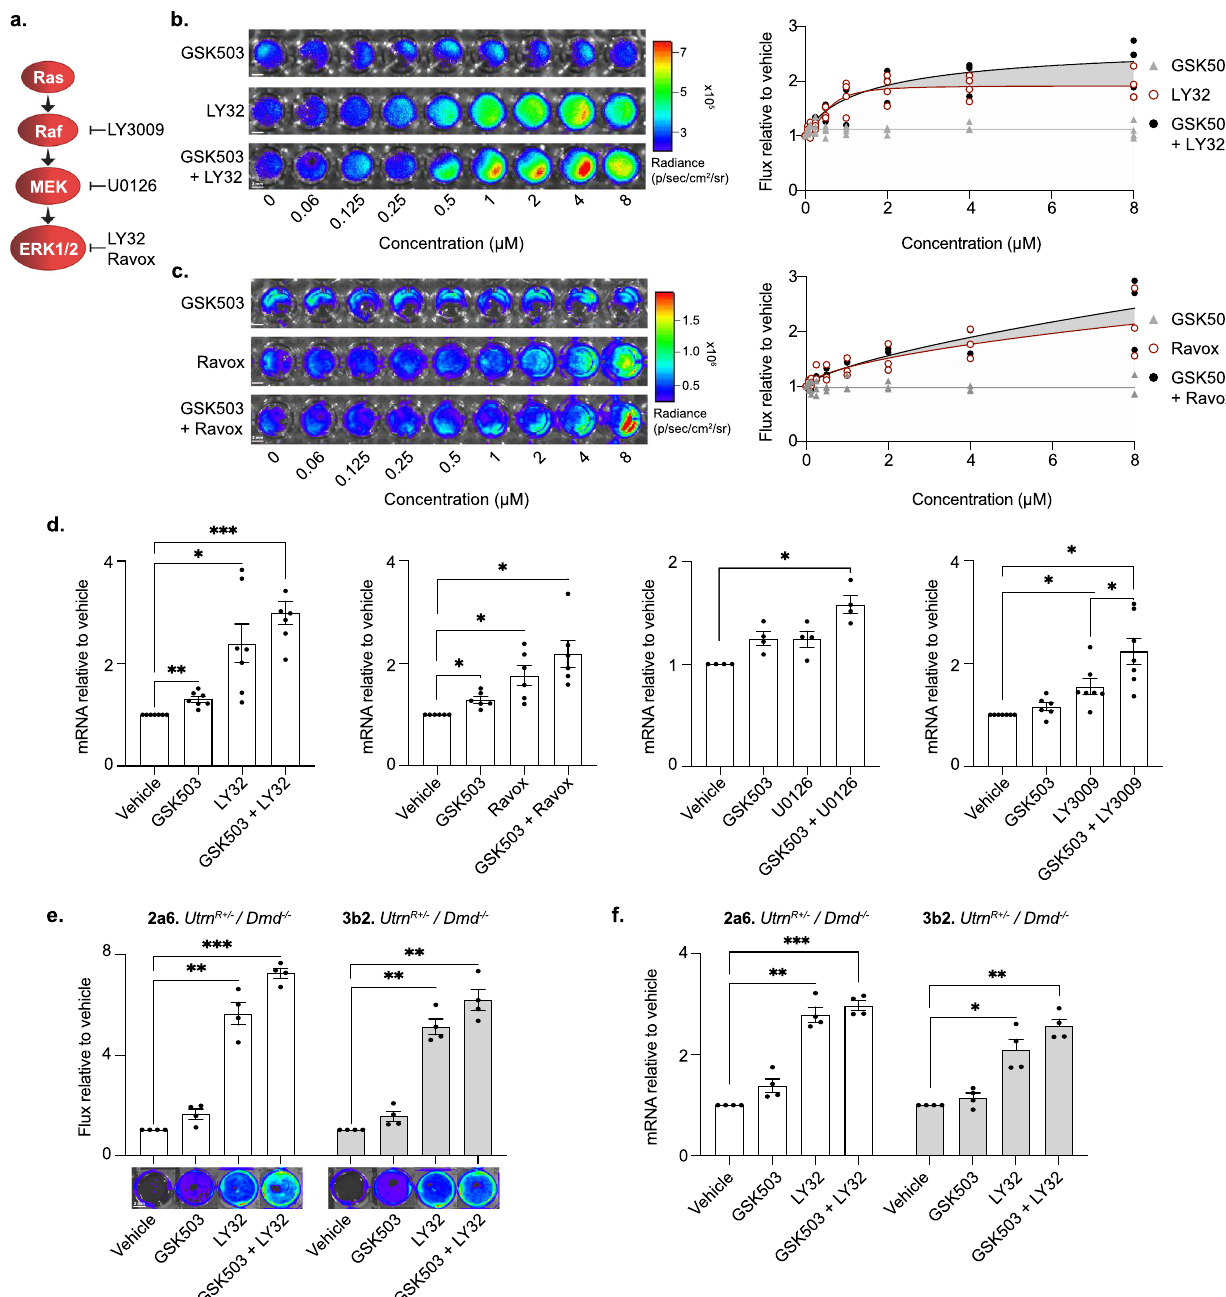
Fig. 5 ERK inhibitors combined with EZH2 inhibitors increased Utrn expression in adult myoblasts. a Schematic of the ERK signalling pathway and the inhibitors used in this study. b Bioluminescence image (left) and quanti fi cation of fl ux (right) of U22 A5 myoblasts after 24 h treatment with EZH2i GSK503 (grey triangles) or ERKi LY32 (red open circles) alone or in combination (black closed circles). LY32 treatment caused a dose-dependent increase in fl ux which was further ampli fi ed by the addition of GSK503 (shaded area). c As in b , for U22 A5 myoblasts treated with EZH2i GSK503 (grey triangles) and ERKi Ravox (red open circles) either alone or combined (black closed circles). A dose dependent increase in fl ux was observed after Ravox treatment and this was increased upon the addition of GSK503 (shaded area). d RT-qPCR of U22 A5 myoblasts after 24 h treatment with GSK503 and ERK pathway inhibitors (at 10 µ M), applied either alone or combined; increased Utrn mRNA upon treatment with ERK pathway inhibitors was ampli fi ed by the addition of GSK503. One-way ANOVAs (in order: p = 0.0012, p = 0.0047, p = 0.0036, p = 0.0015) with Sidak ’ s multiple comparisons test was used to compare between groups. e , f Dmd -de fi cient U22 A5 myoblast lines 2a6 and 3b2 were generated using CRISPR/Cas9 (details in Fig. S5). Utrn R bioluminescence (blue green) after treatment with GSK503 or LY32 (10 µ M) alone or in combination is shown in e and RT-qPCR analysis of Utrn mRNA expression is shown in f . For each clone, comparisons between treatment groups were performed with one-way ANOVAs ( e , p = 0.0009 both, f p < 0.0001 and p = 0.0023) with Dunnett ’ s multiple comparisons test. Expression levels were normalised to 18 S and Tbp and shown relative to the vehicle treated control ( d , f ). Bars show mean + / − SEM with adjusted p values: * p < 0.05, ** p < 0.01, *** p < 0.001) ( d – f ).